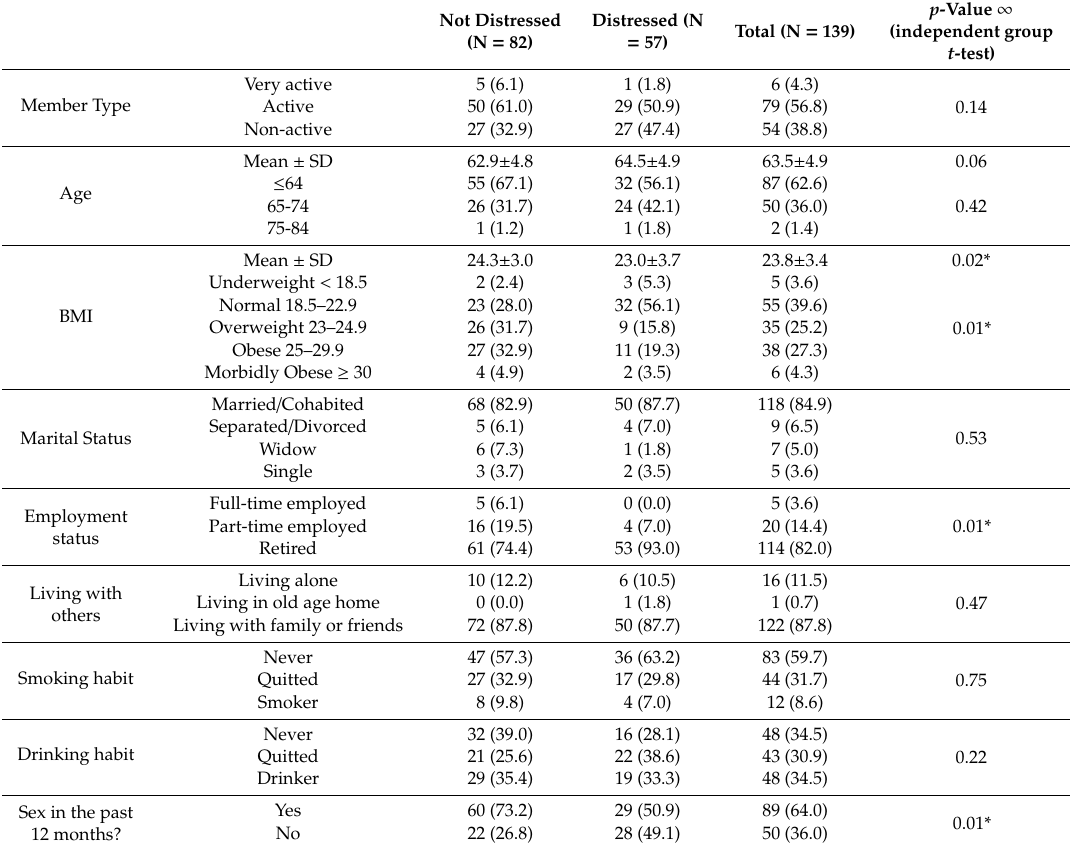
Table 1. Socio-demographic